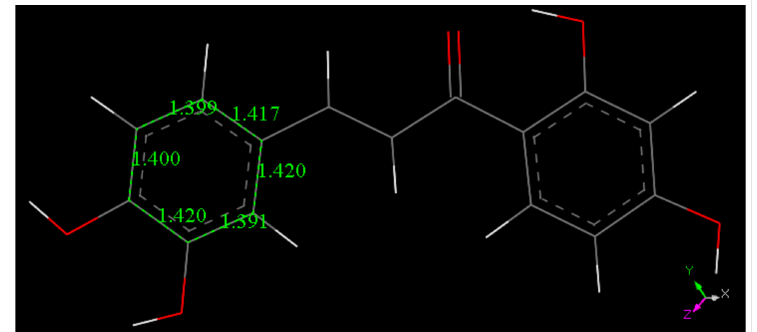
Figure 7. DFT minimum of energy structure of Butein ( 1 ). Relevant bond distances of ring B are indicated.